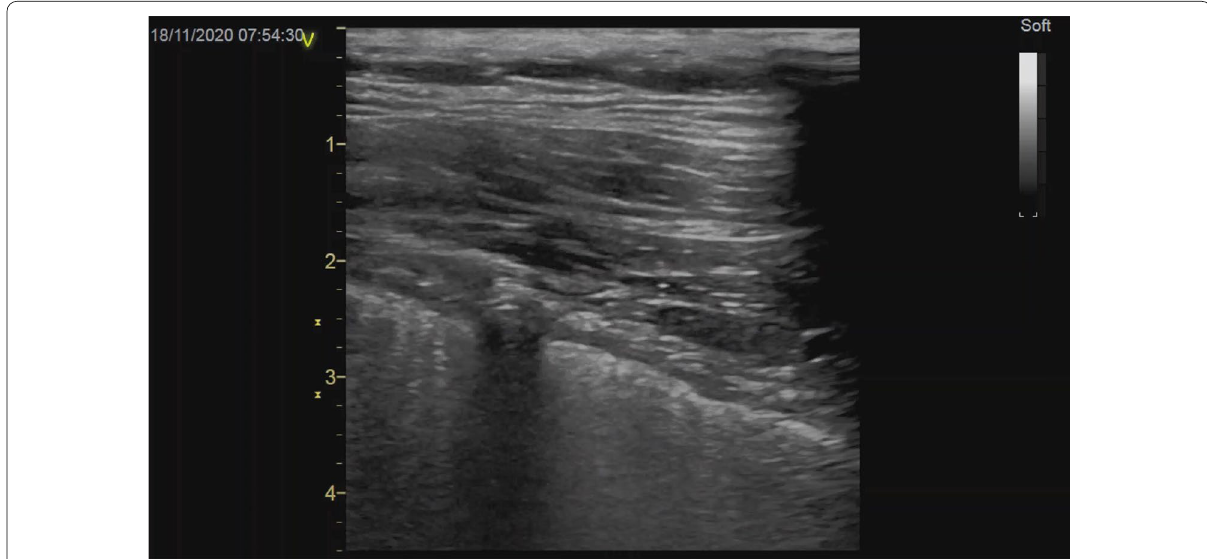
Fig.1 Chest ultrasound of the anterior chest wall in a Covid-19 ARDS patient after drainage of a pneumothorax due to barotrauma. The linear transducer depicts a chest drain in the transverse plane in between the enhancing visceral and parietal